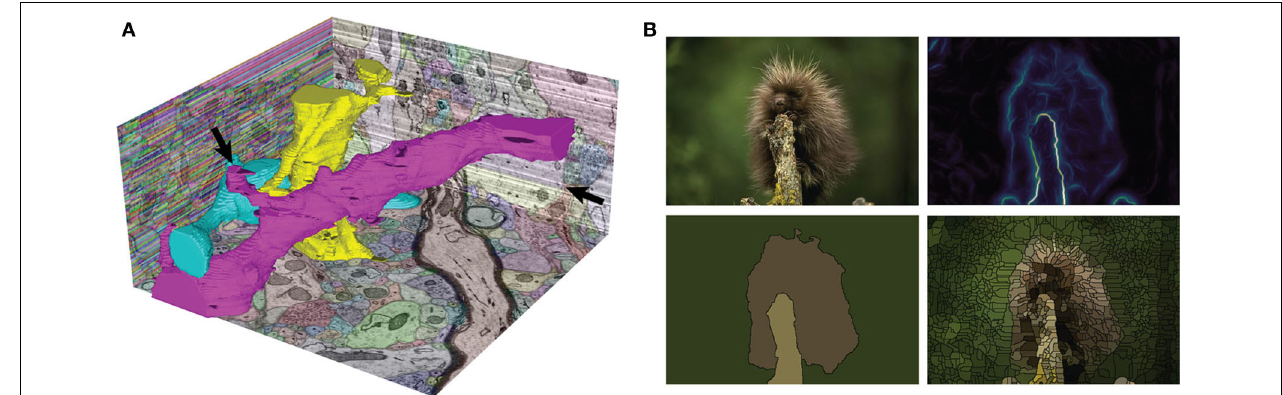
FIGURE 1 | Two sample automatic segmentations performed with gala. (A) The SNEMI3D test data. The XZ plane (left) shows the initial, extremely oversegmented superpixel map, while the YZ (right) and XY (bottom) planes show the final segmentation returned by gala. Three complete neuronal segments are highlighted in 3D. Note that the segmentation is not perfect—stubs on the magenta 3D segment are candidates for missed